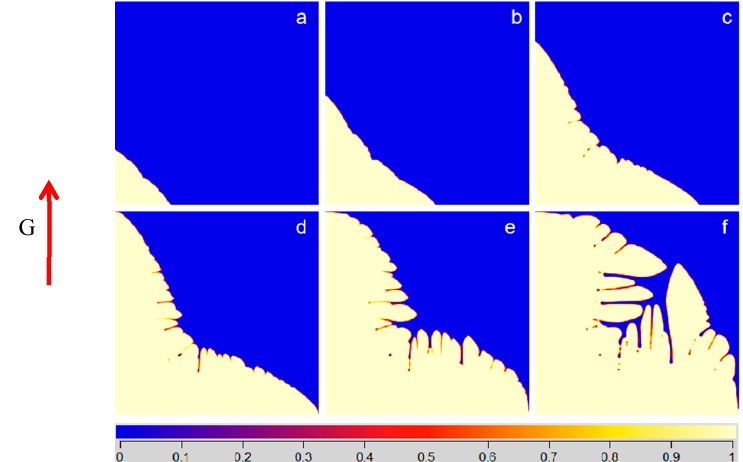
Figure 3. Grain growth with time of Ti–3Al–0.9Fe alloy: ( a ) 4 ms, ( b ) 8 ms, ( c ) 12 ms, ( d ) 16 ms, ( e ) 20 ms, ( f ) 30 ms.